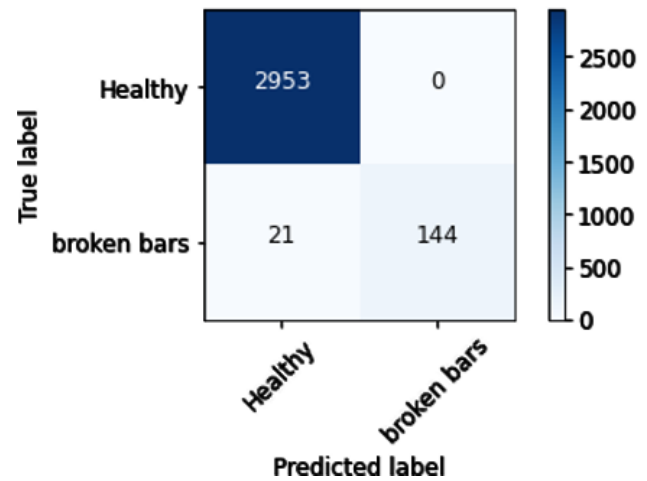
Figure 9. Confusion matrix of the ANN trained with synthetic data.